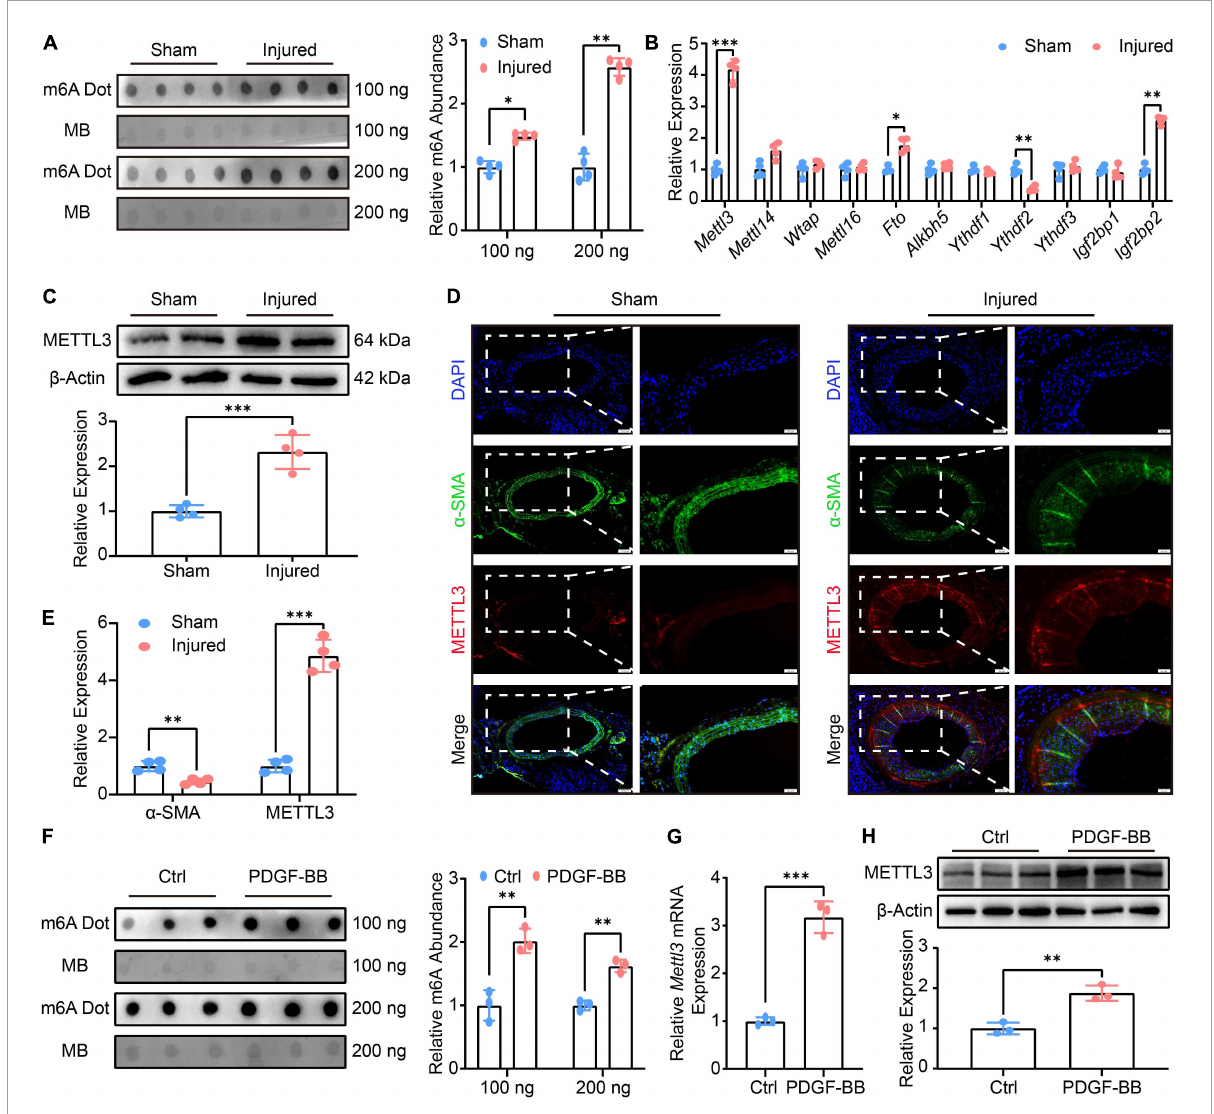
FIGURE1 Methyltransferase like3 (METTL3) is up-regulated in phenotype switched vascular smooth muscle cells (VSMCs) in vivo, in vitro, and ex vivo and is involved in global N6-methylatidine (m6A) upregulation. (A) Representative m6A Dot Blot image (left panel) and quantification (right panel) of sham-operated and balloon-injured carotid arteries 14 days after surgery ( n = 4). (B) Quantitative analysis of m6A-related genes detected by RT-qPCR ( n = 4). (C) Representative Western blot images (upper panel) and quantification (lower panel) of METTL3 ( n = 4). (D,E) Representative immunofluorescence images and quantification showing METTL3 and α -SMA expression (scale bar = 100 µ m). (F) Representative Dot Blot image (left panel) and quantification (right panel) showing VSMCs m6A modification treated with or without PDGF-BB ( n = 3). (G) RT-qPCR quantification of Mettl3 expression ( n = 3). (H) Representative Western Blot image (upper panel) and quantitative analysis (lower panel) of METTL3 level. Data are presented as mean ± SD. ∗ p < 0.05, ∗∗ p < 0.01 and ∗∗∗ p <